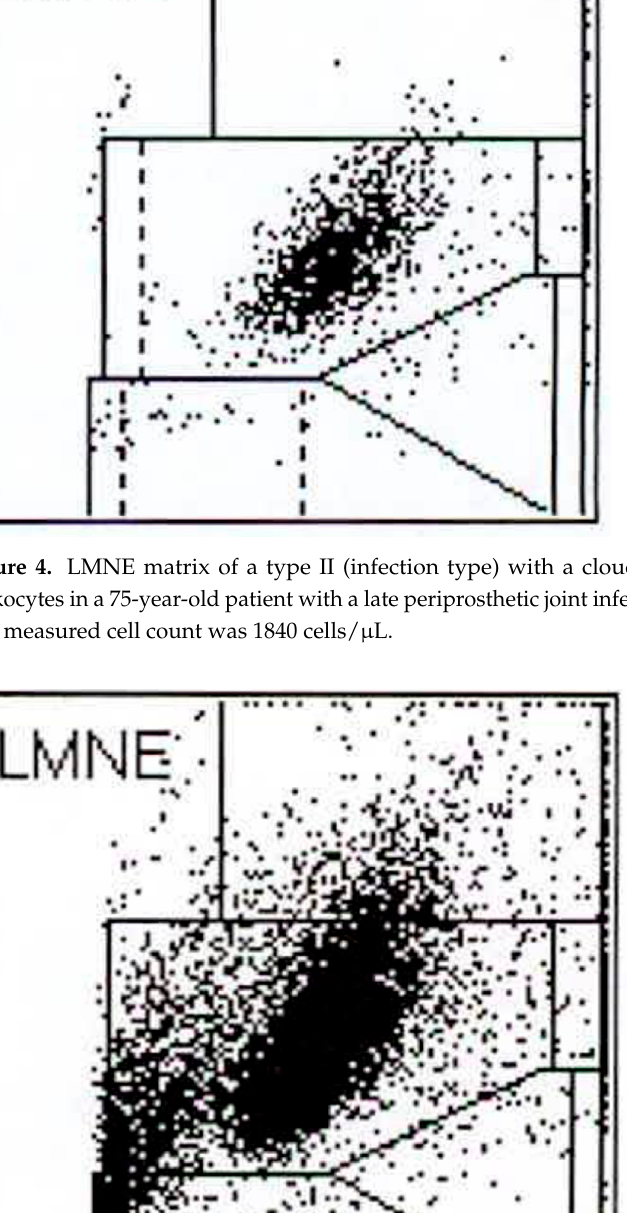
Figure 3. ( a ) LMNE matrix of a type I with polyethylene wear particles produced in a laboratory. The cloud is at the top in the NOISE area. ( b ) LMNE matrix of a type I with metal debris particles in a 73 ‐ year ‐ old male patient with an articulation of a ceramic head on the inner side of a cup with disturbed inlay. The cloud is at the left bottom close to the NOISE area and the distribution is “L” ‐ shaped. The measured “cell count” was 6700 cells/ μ L.